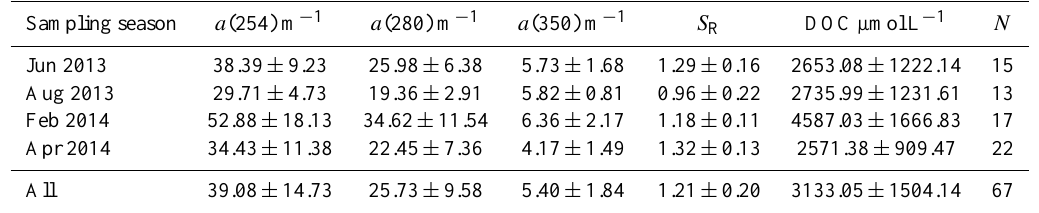
Table 3. Mean values of DOC concentration and CDOM absorption coefficients groups in different seasons. S R : the slope ratio of S 275–295nm : S 350–400nm .